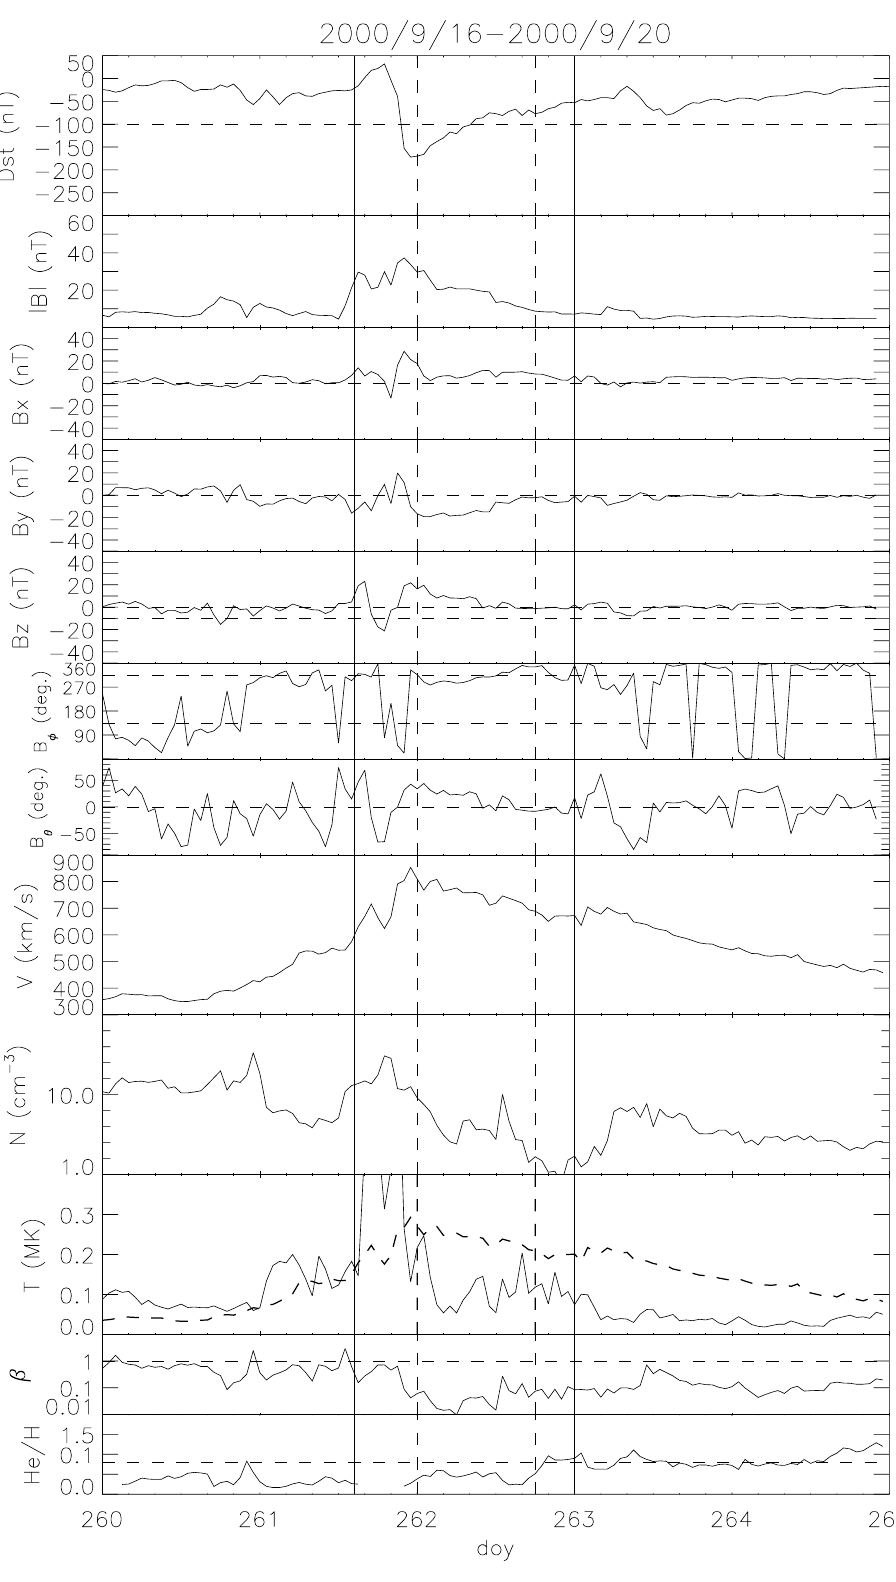
Fig. 11. D st index and solar wind parameters of storm no. 24. Two vertical solid lines show the duration of the geomagnetic storm and two vertical dash lines show the duration of a magnetic flux